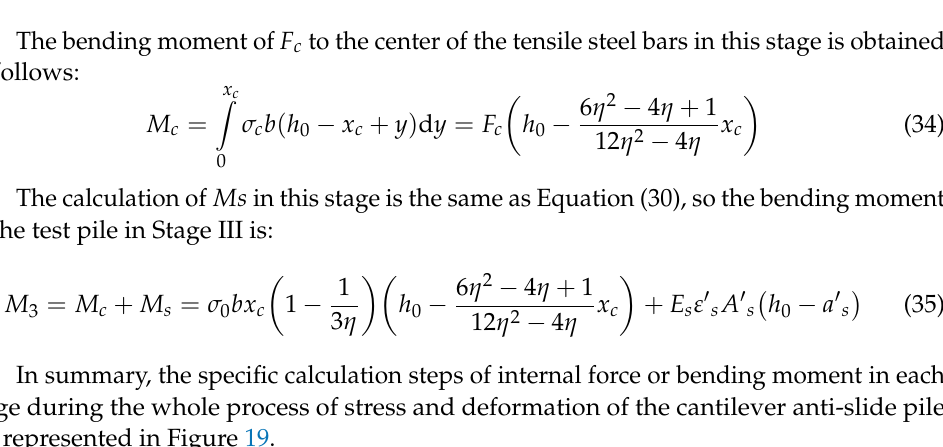
Figure 18. Stress and strain diagrams of the anti-slide pile in normal section stage III. ( a ) Distribution of average strain; ( b ) distribution of normal stress.